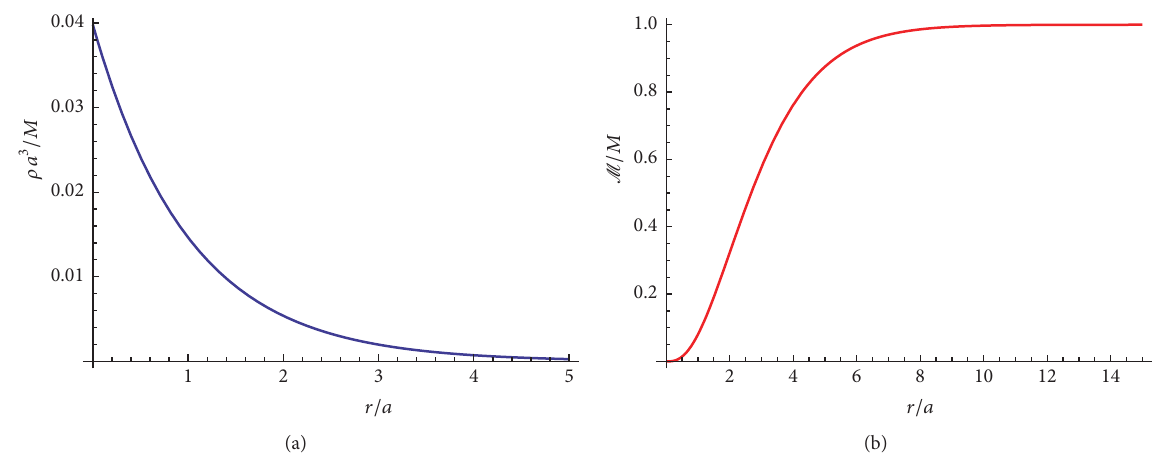
Figure1:Plotsofthemassdensityequation(1)(a)andofthemassdistributionequation(2)(b).Notethatwhenwetakethelimit 𝑎 → 0 ,except the origin with M (0) = 0 , the mass ratio M (𝑟)/𝑀 approaches 1 at other radii due to 𝑟/𝑎 → ∞ , which indicates that the mass distribution goes to the step